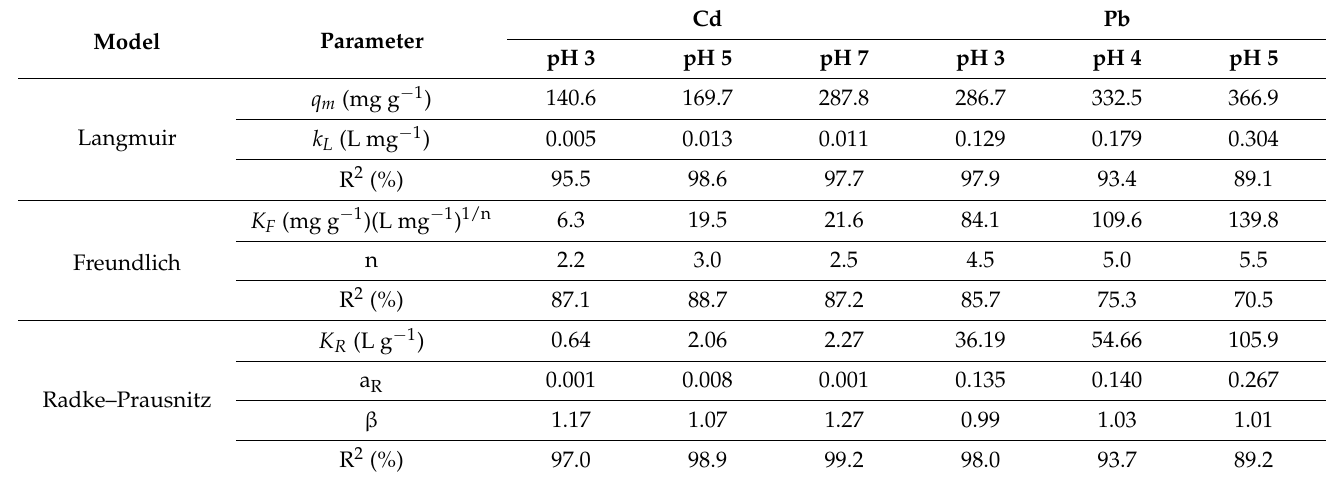
Table 5. Parameters of adsorption isotherm